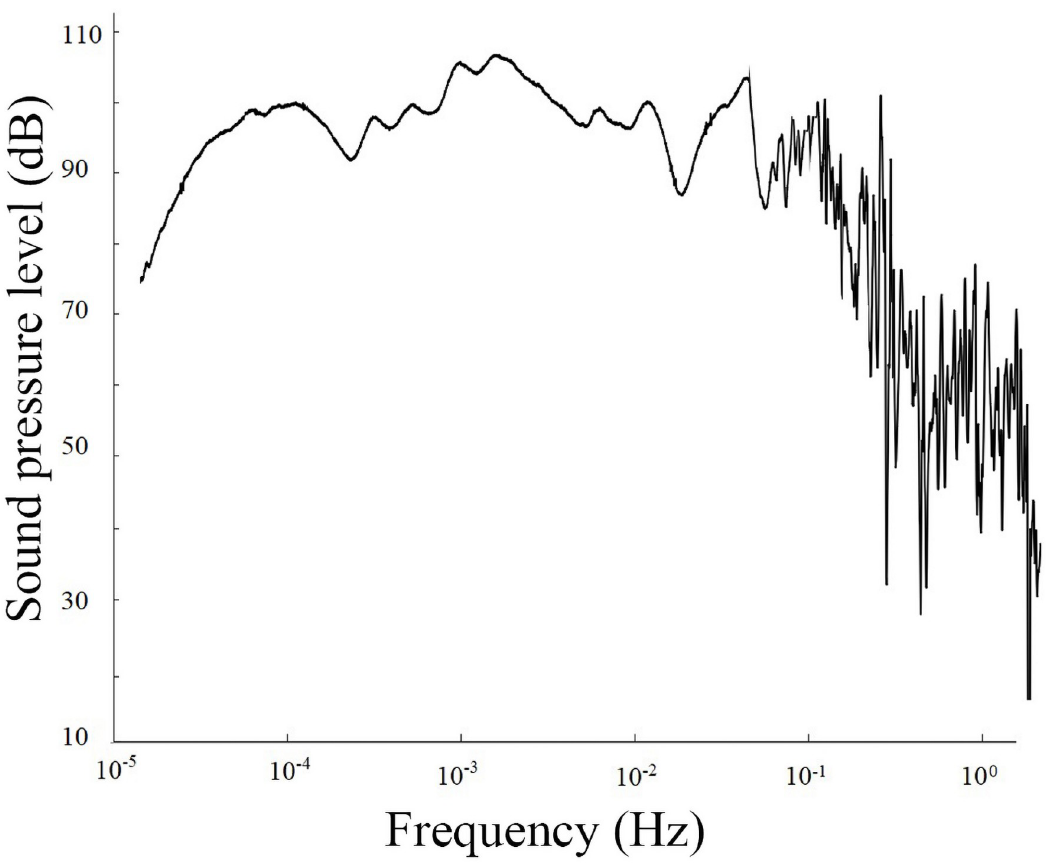
Fig 4. Frequency of anomalous infrasound signals on September 18,